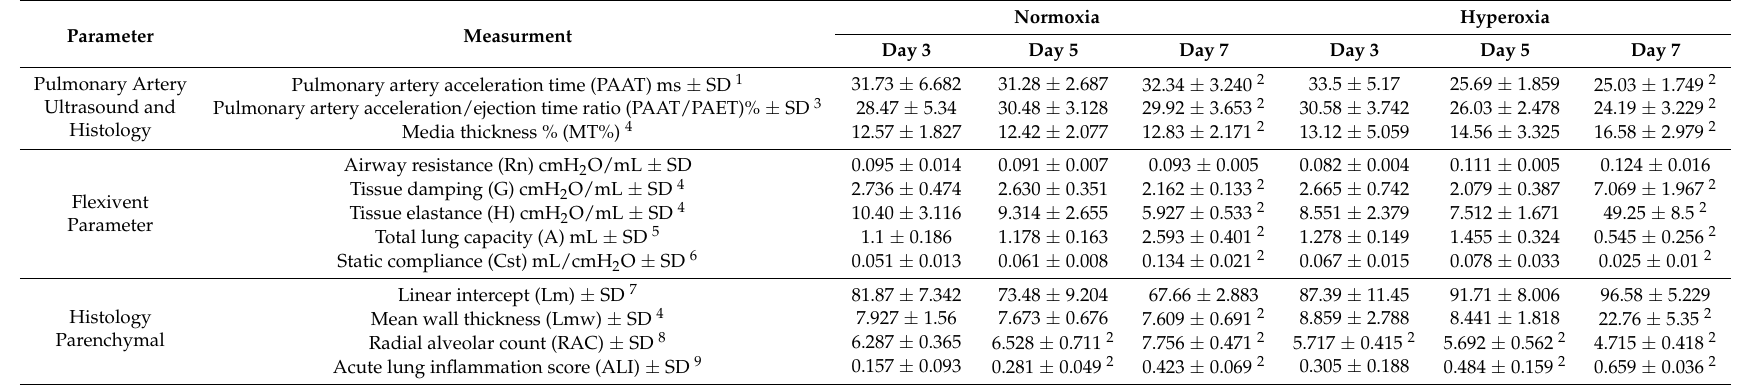
Table 1. Two-way analysis of variance (ANOVA)